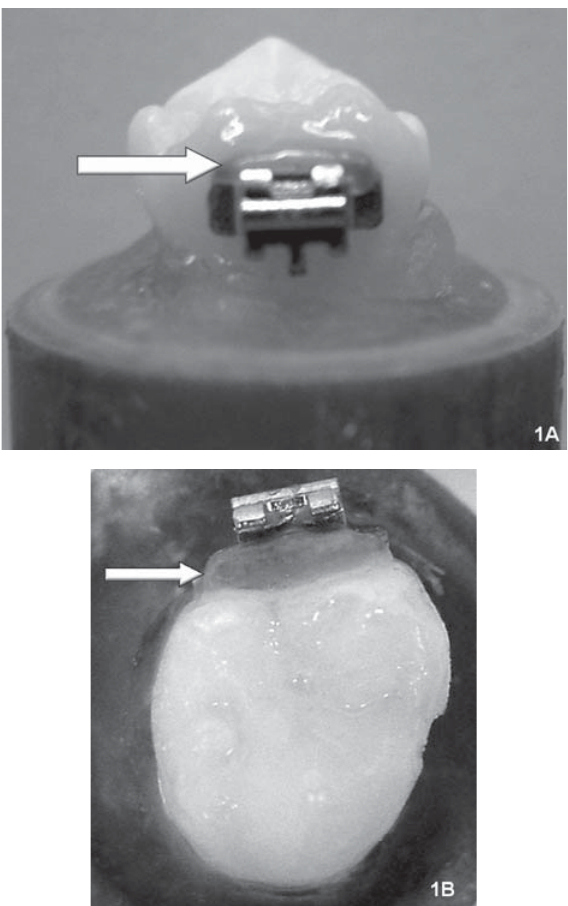
Figure 1- Specimen preparation. Group 1: with